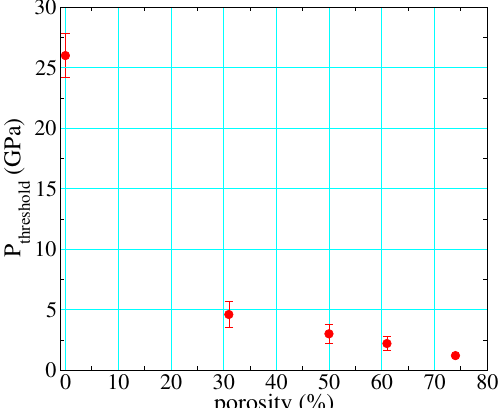
Figure 13. Threshold pressure for shock-driven decomposition of PMDI polyurethane along its principal Hugoniot, as a function of initial